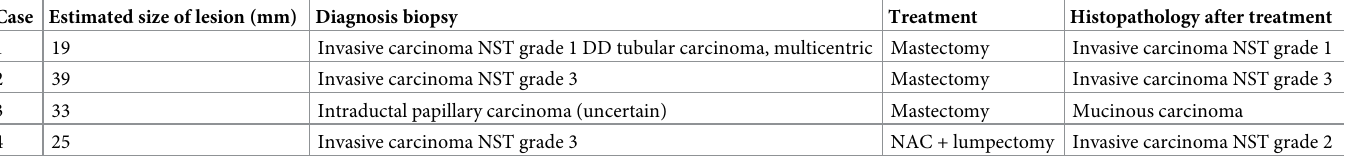
Table 2. Characteristics of the four breast cancer patients and subjects, studied in detail.